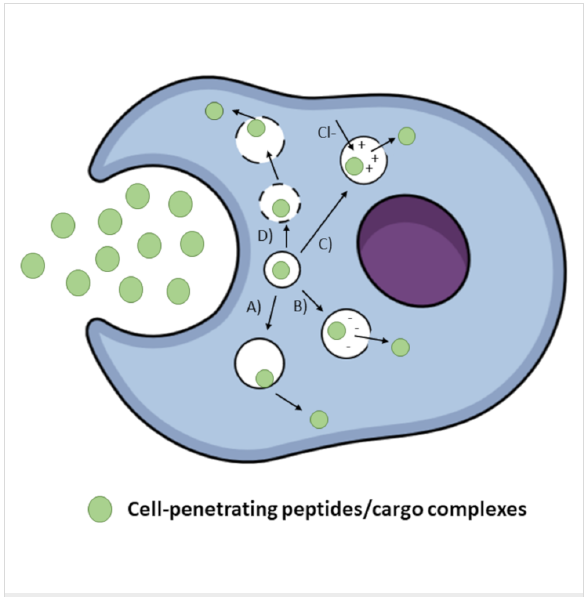
Figure 4: Most commonly used strategies for improving the endo- somal release of CPPs. A) Fusogenic lipids, B) pH-sensitive mem- brane disruptive peptides, C) ‘Proton sponge’ effect, D) Endosomolytic agents such as